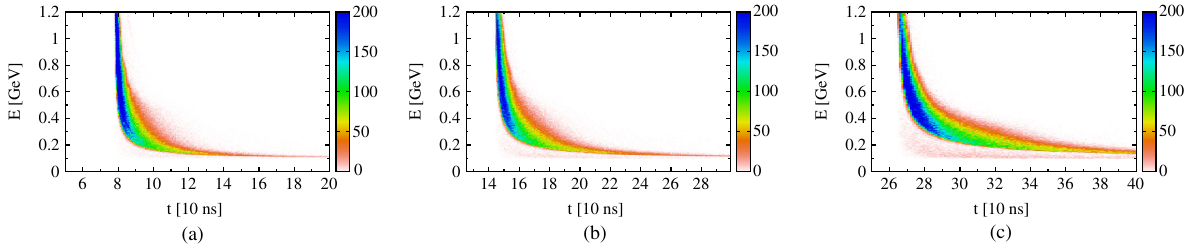
FIG. 7. Progression of the longitudinal phase space of pions exiting a 4 m long tapered solenoid. (a) z ¼ 20 m . (b) z ¼ 40 m . (c) z ¼ 80 m .